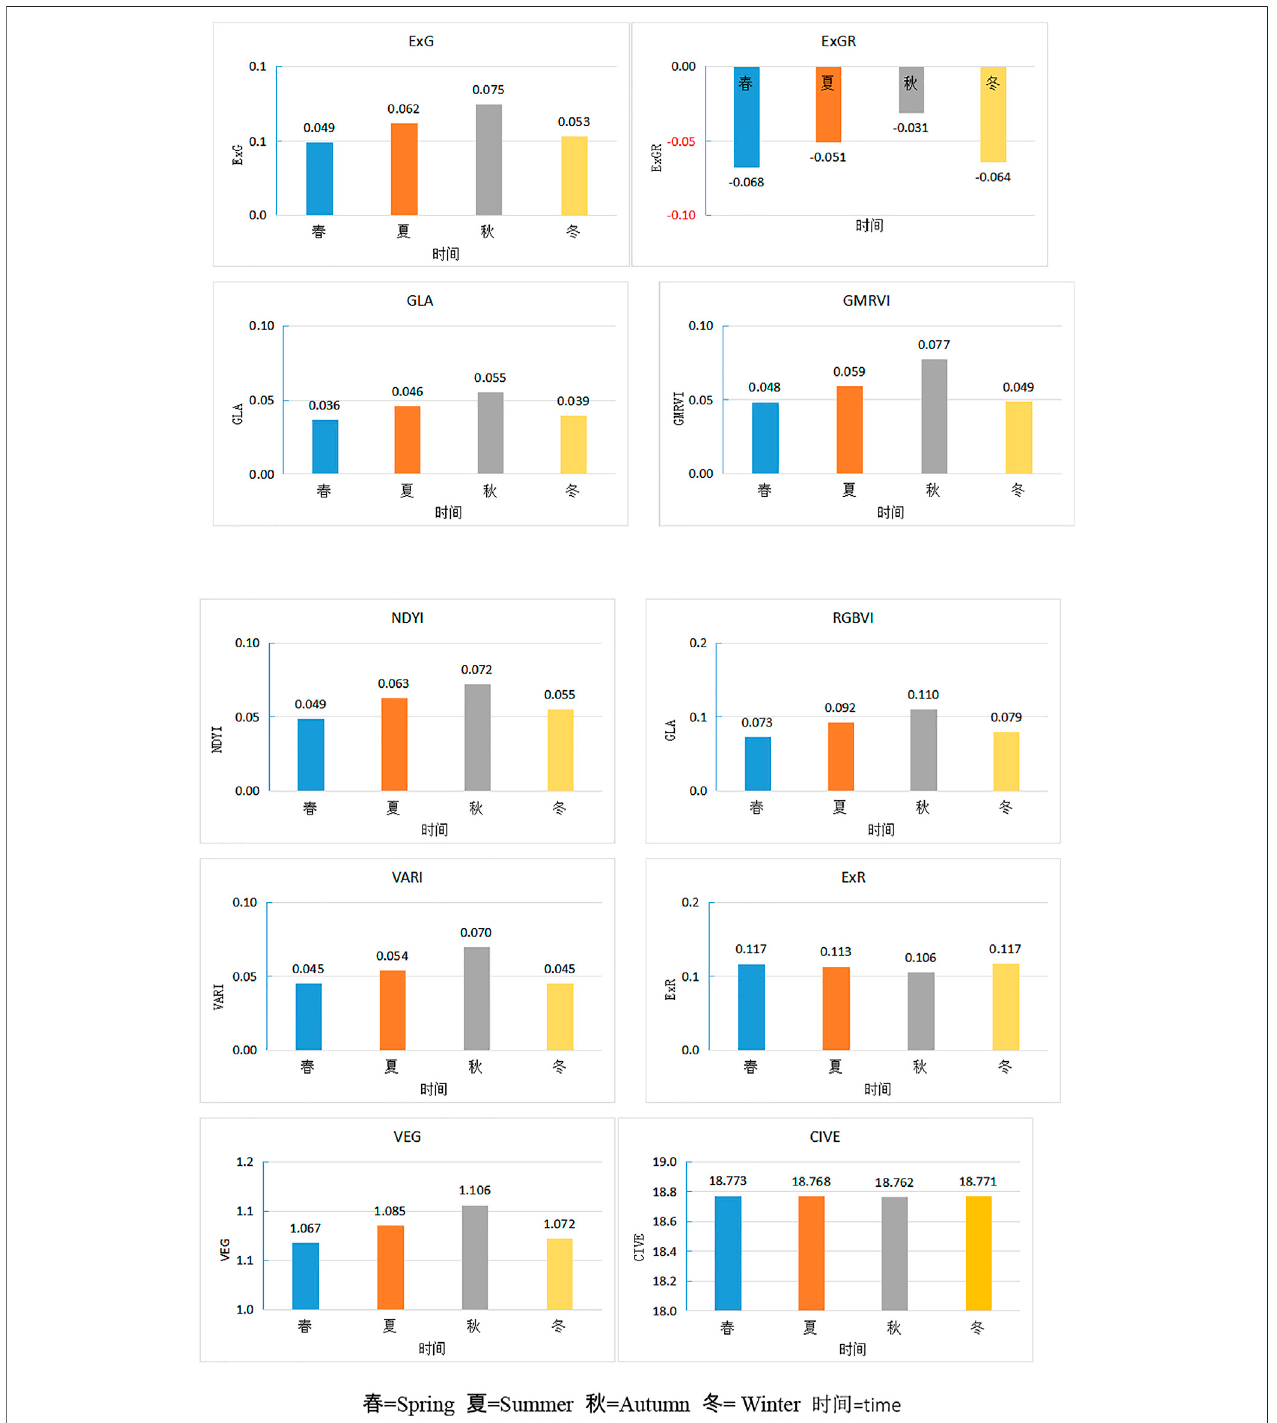
FIGURE 4 | Seasonal changes of mangrove visible vegetation